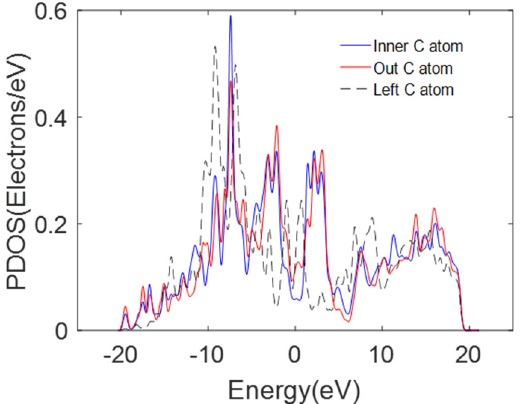
Figure 16. The PDOS for the carbon atoms in the DWCNT. Fermi energy is set to 0